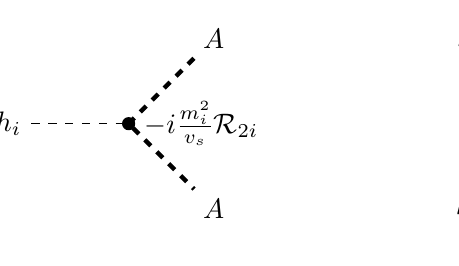
Figure 1 . Vertices relevant for the pGDM